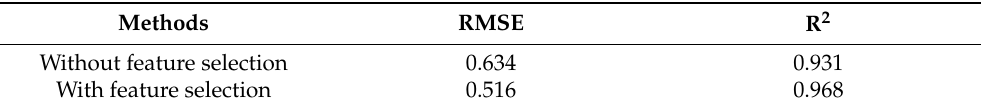
Table 3. Hyperparameters of the corrosion weight gain prediction model with feature selection.